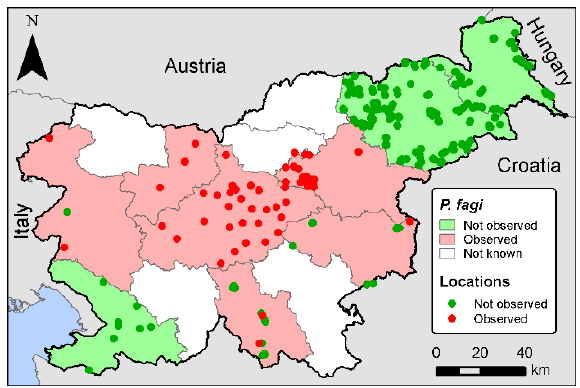
Figure 1. Distribution map of Pseudodidymella fagi in Slovenia by regional units of the Slovenia Forest Service along with locations that were checked for presence of the pathogen.